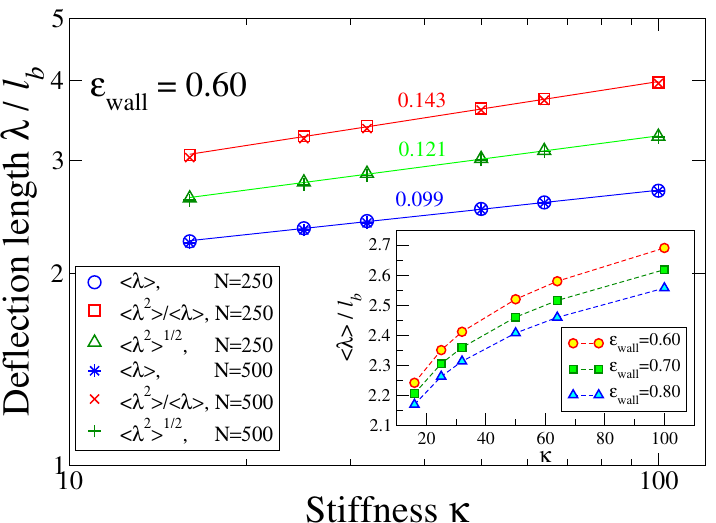
Figure 5. Variation of the deflection length λ with chain stiffness κ at (cid:101) wall = 0.60 for chains of length N = 250 and 500 in log-log coordinates, testing different definitions of the deflection length, as indicated. Slopes are displayed above the respective straight lines. The inset shows λ / (cid:96) b vs. stiffness κ for three different strengths of (cid:101) wall in normal